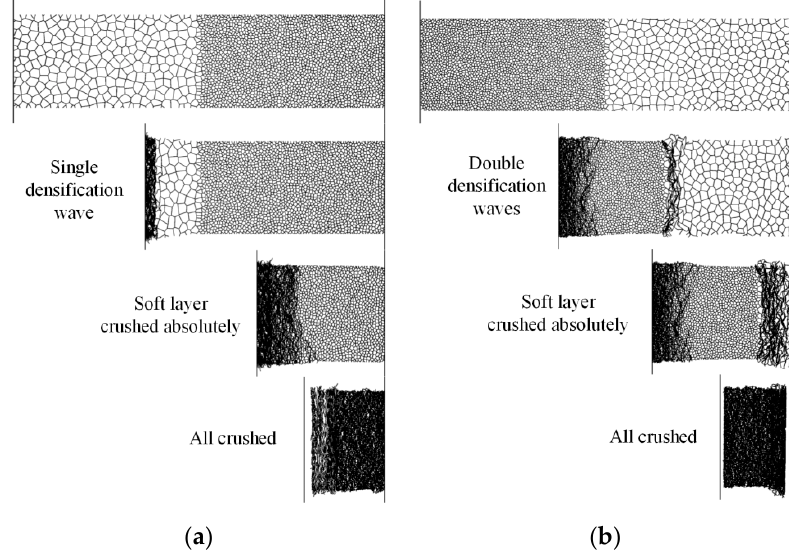
Figure 8. Deformation processes induced from FE simulations. ( a ) Positive gradient specimen, g = 0.3; ( b ) negative gradient specimen, g = − 0.3. Table 6. Comparisons of average cross-section thicknesses of deformed